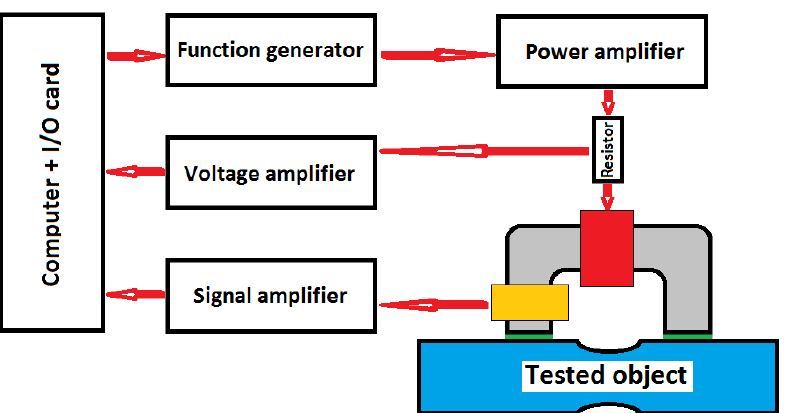
Figure 3. Block diagram of the MAT measuring system: The soft magnetic yoke (grey) magnetizes the blue tested object via the red driving coil (through the green non-magnetic thin spacers; this spacer is not necessary in all measurements) using a series of minor hysteresis loops with increasing amplitudes. The yellow sensing coil picks up the resulting signal, which carries information on the actual differential permeability, µ, of the closed magnetic circuit (and, thus, on the quality of the tested object). The amplitude at which the signal displays the top sensitivity with respect to the material quality of the object is singled out as the most responsive MAT measurement.